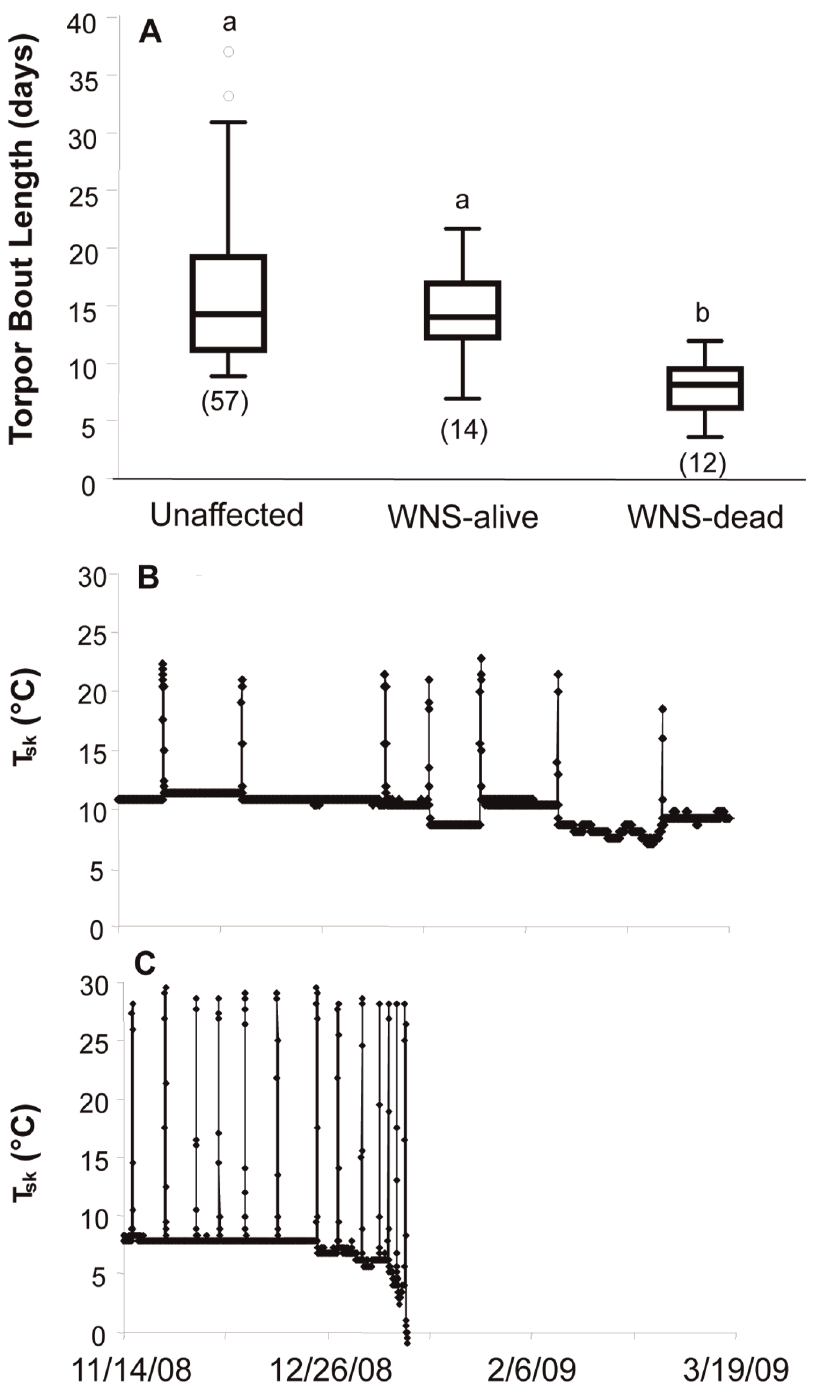
Figure 2. Torpor bout length (TBL) in days by WNS status. WNS was associated with decreased TBL: bats that were affected by WNS but still alive at the collection of dataloggers (March) had shorter TBLs than unaffected bats (but this difference was not significant). Significantly shorter TBLs were seen in WNS-affected bats that were found dead at the time of datalogger collection compared to affected but alive bats (2A). Bats were categorized as: unaffected, WNS-affected and alive at time of datalogger removal (‘WNS-alive’), and WNS-affected and dead when loggers were removed in the spring (‘WNS-dead’). Numbers in brackets indicate sample size and boxes sharing the same letter are not significantly different from each other. Boxes depict the 25th and 75th percentiles, lines within boxes mark the median, and whiskers represent 95th and the 5th percentiles. Outliers are indicated with open circles. Additional panels illustrate sample temperature profile of an unaffected (B) and an affected (C) bat, during the winter of 2009. The bat illustrated in C displayed daily arousals at the end of its life, which was seen in several of these animals. Each of the ‘WNS- dead’ bats died at the end of their last arousal.